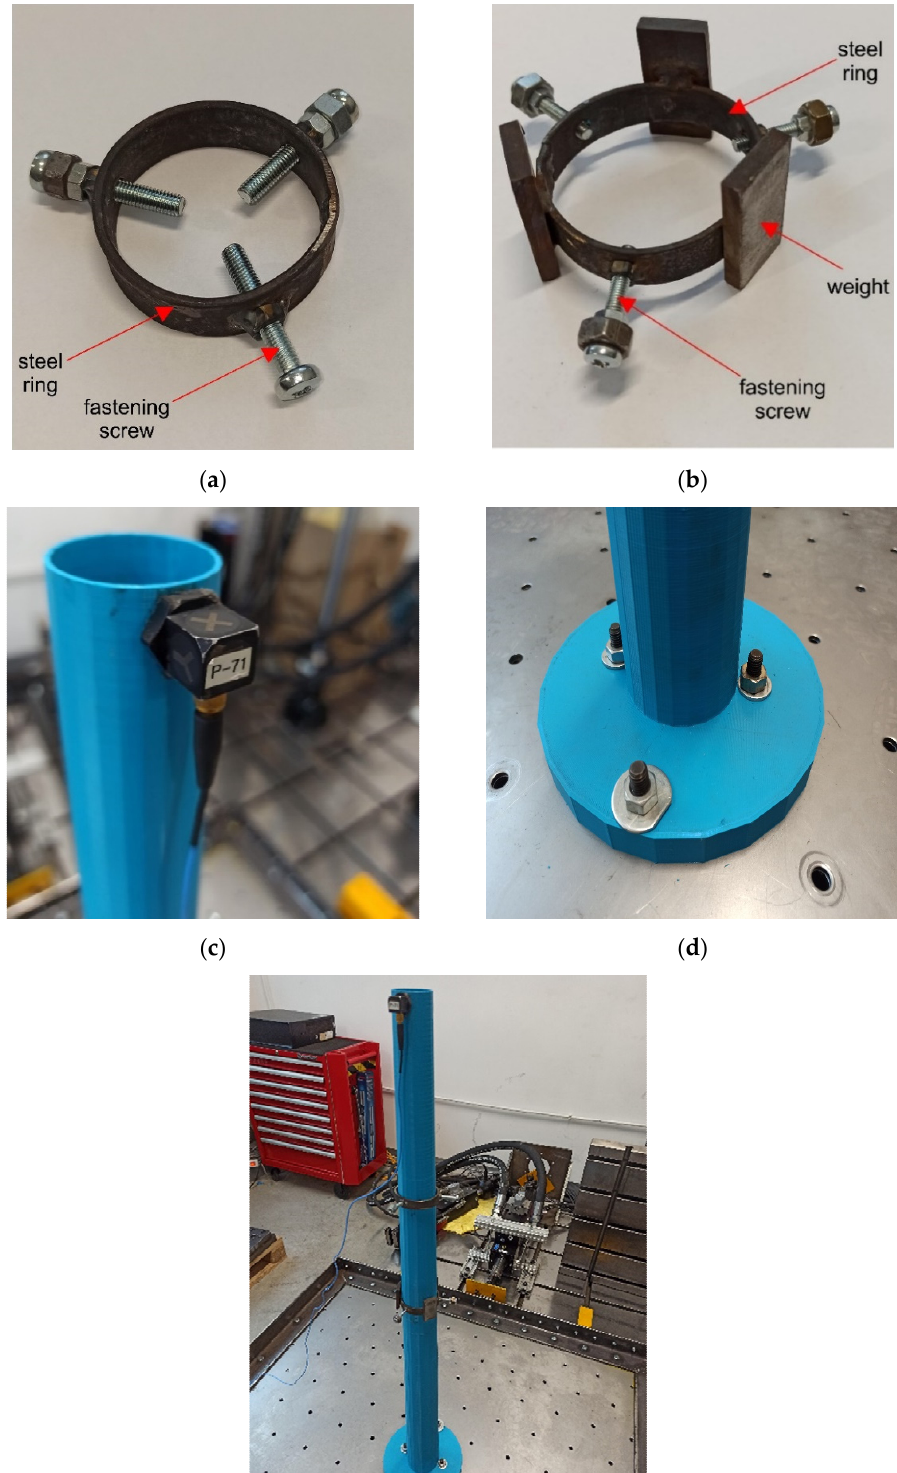
Figure 14. The main technical details of the model: ( a ) The clamp located on the level of 0.75 m; ( b ) the clamp located on the level of 0.45 m; ( c ) the accelerometer mounted at the top of the model; ( d ) the fixed support the model; ( e ) the final view of the chimney’s model, with the additional masses, fixed to the shaking table platform.